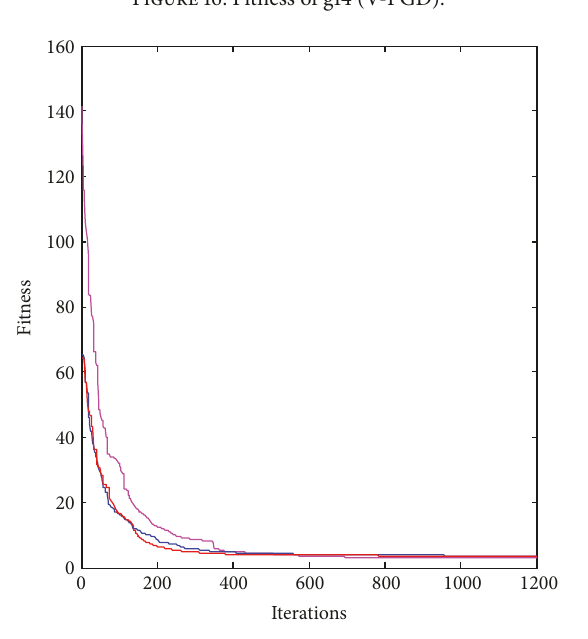
Figure 17: Fitness of g K (V-PGD).